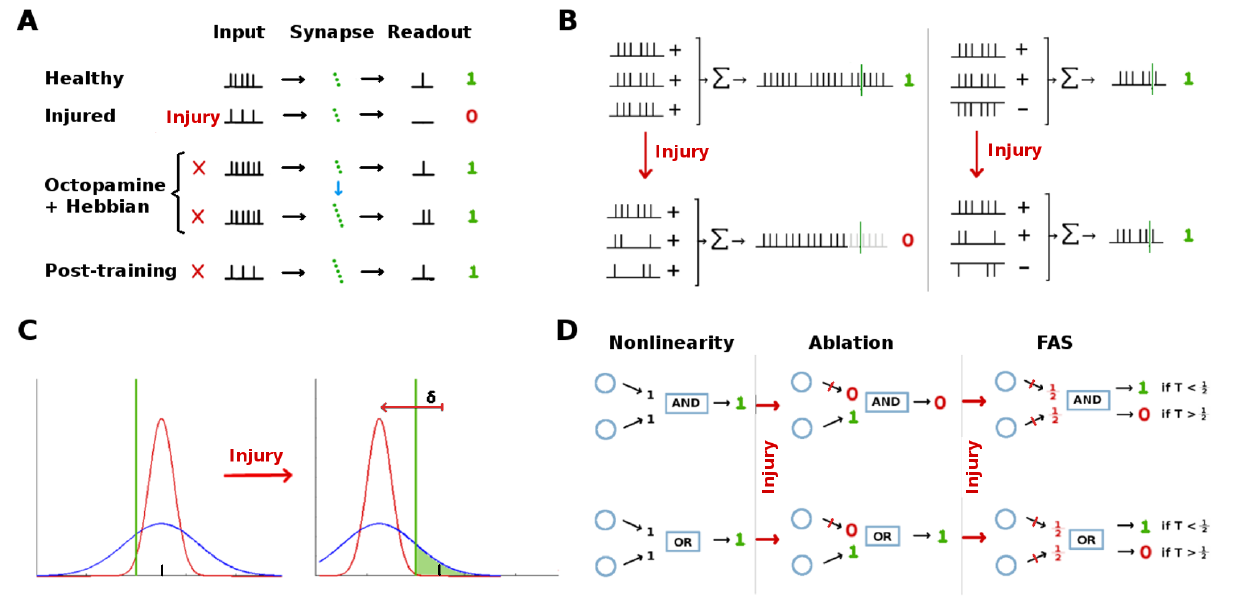
Figure 9. Injury mitigation hypotheses: In a cascaded network, various architectures can mitigate the effects of injury to upstream neurons by protecting or restoring functionality of downstream units. ( A ): Learning itself can compensate for injury: Octopamine temporarily stimulates the damaged neuron, allowing Hebbian growth to strengthen downstream synaptic connections.Though the injured neuron’s signal is not restored, the downstream neurons receive an amplified input, cancelling out the injury. ( B ): Parallel inhibitory channels can reduce the effect of generalized injury because damage is split between excitatory and inhibitory signals, canceling out losses in terms of the inputs to downstream neurons. ( C ): Wide noise envelopes on upstream neuron outputs can protect the strongest stimulus responses from injury-induced attenuation δ , to the degree that their std dev σ > δ . This allows the injured neuron’s strongest responses to still exceed their activation threshold (green line) for downstream neurons, protecting downstream functionality. ( D ): Two simple examples of non-linearities that can result in qualititative change in the relative effects of ablation and FAS-like injury: In an AND gate, ablation can have a worse effect than FAS downstream, depending on the gate’s input threshold T . In an OR gate, ablation can be harmless, while FAS can have a worse effect downstream, depending on T